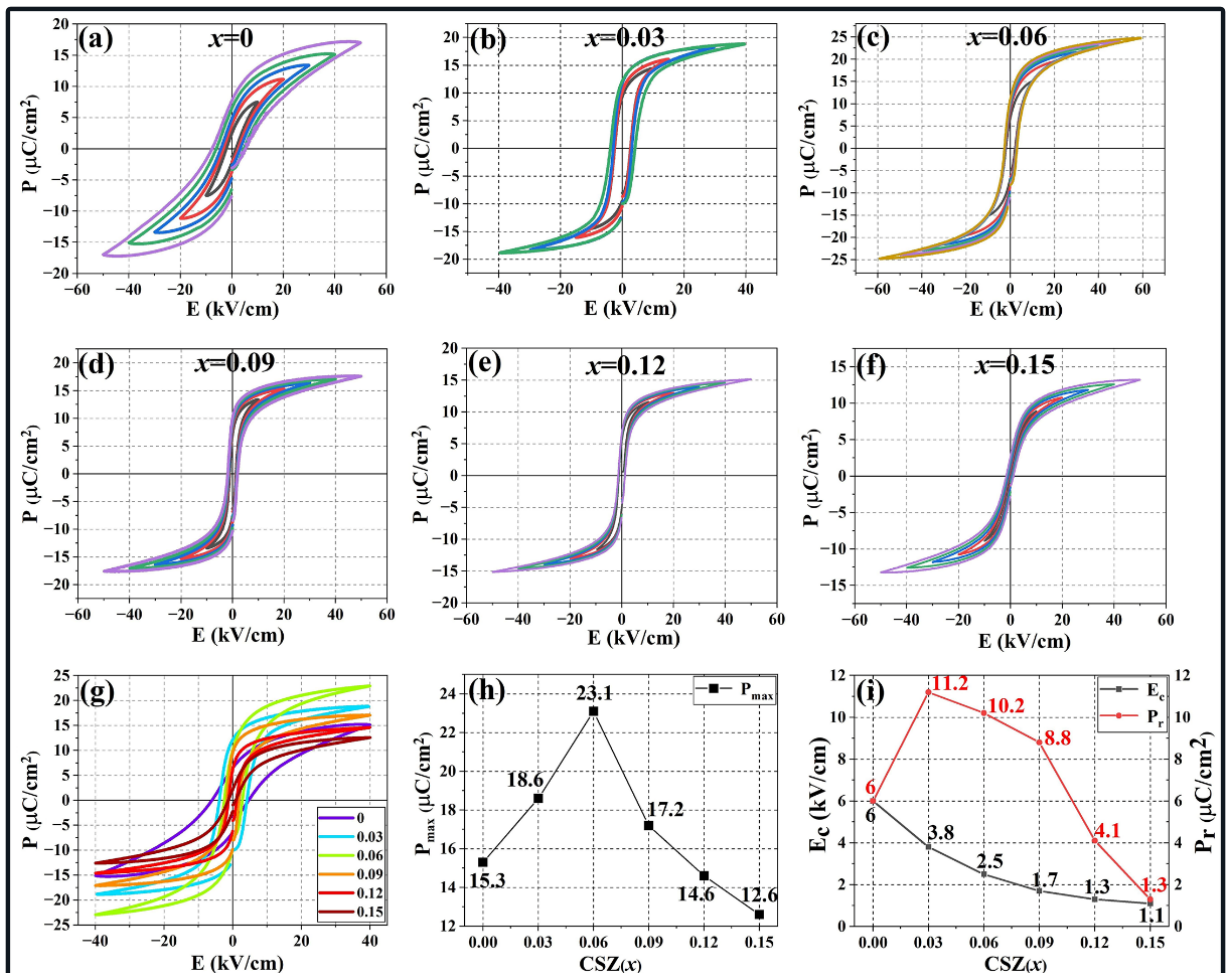
Figure 6. Polarization - electric field hysteresis loops measured at room temperature under different electric-field for the (1 − x )BT- x CSZ ceramics: ( a ) x = 0, ( b ) x = 0.03, ( c ) x = 0.06, ( d ) x = 0.09, ( e ) x = 0.12, and ( f ) x = 0.15. ( g ) The P-E loops of the studied ceramics measured at ±40 kV/cm. ( h , i ) Evolution of the P max , P r , and E c value as a function of the CSZ content.